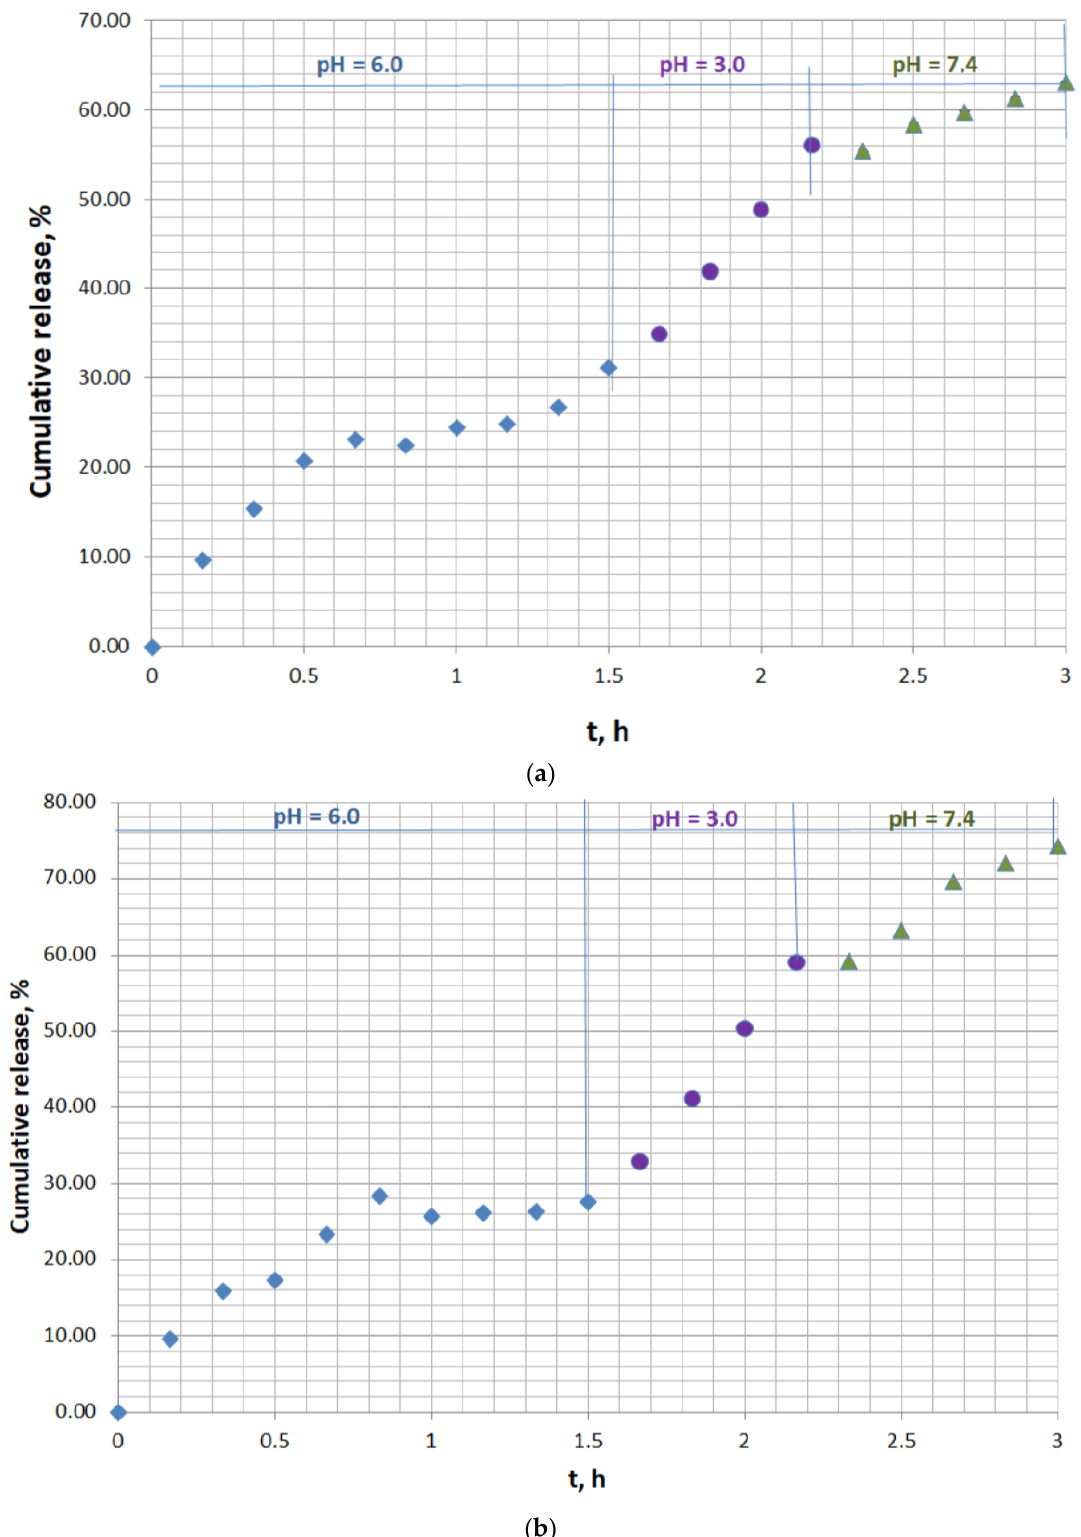
Figure 2. In vitro kinetics release curve of doxycycline from animal feed in simulated gastrointesti- nal and stomach medium: ( a ) solid doxycycline concentration 11.03 µg/mg, doxycycline-loaded fod- der w = 133.3 mg; ( b ) solid doxycycline concentration 41.6 µg/mg, doxycycline-loaded fodder w = 137.8 mg.